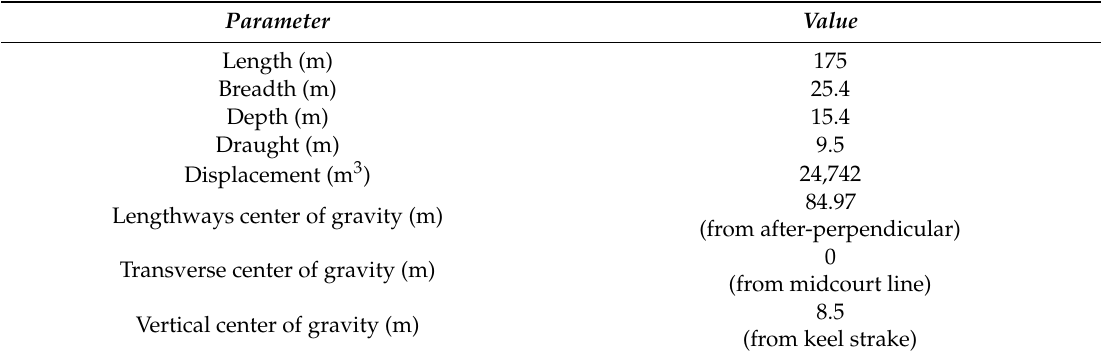
Table 3. Principal dimensions of the S-175 container ship.